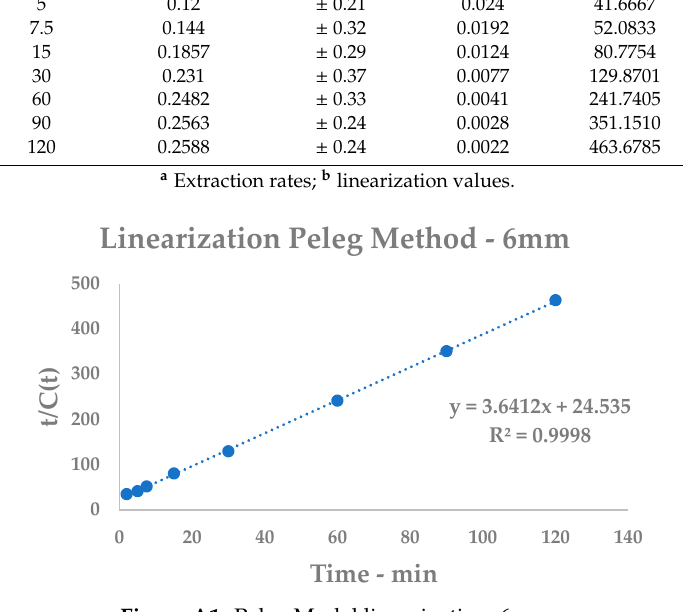
Figure A1. Peleg Model linearization, 6 mm. Table A2. Experimental UAE of 2 mm Curcuma longa L.